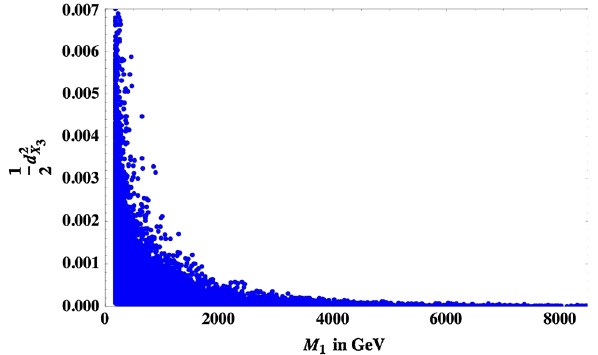
Fig. 1 Maximum deviations from unitarity as a function of M 1 , gen- erated under the condition that Tr ( mm † ) ≤ m 2 t and | η 12 | ≤ 10 −